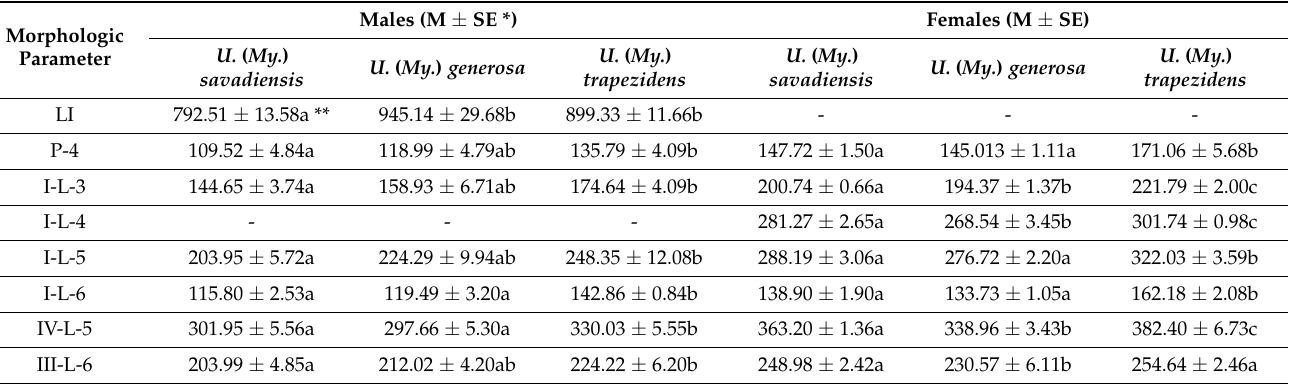
Table 4. Pairwise comparisons of morphological structures between three Myanmaratax subgen. nov. species based on linear dimensions. Abbreviations are given in the “Taxonomic account” section of the